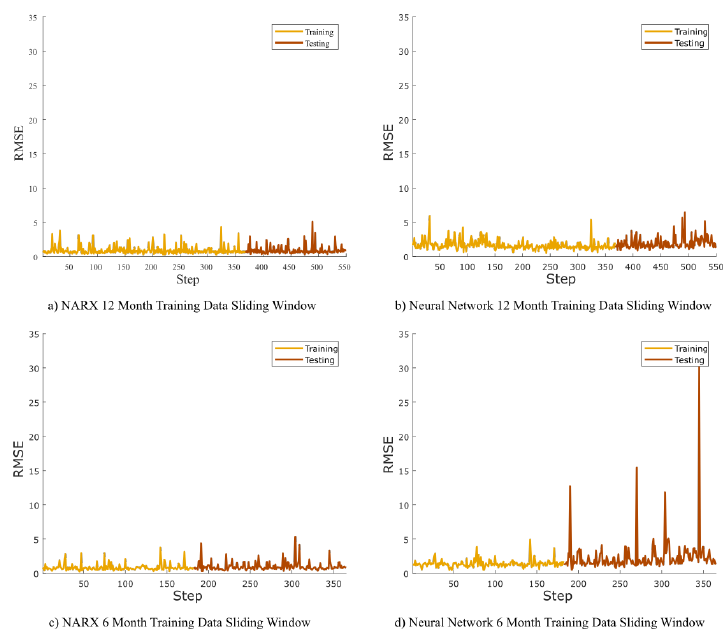
Figure 5. The daily sliding window RMSE for the 10 min resolution NARX and NN